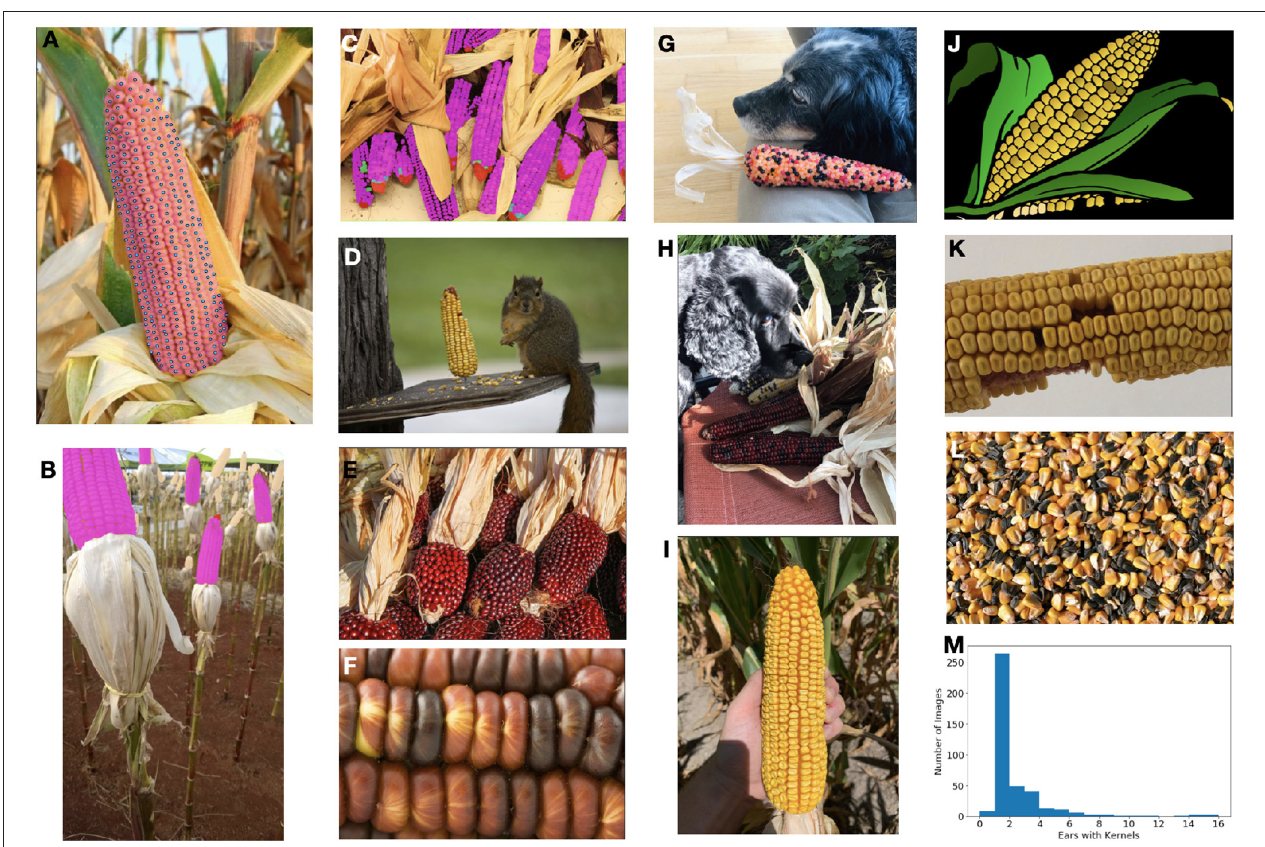
FIGURE 1 | The ultimate goal of this model is count and localize the healthy kernels on ears of corn. (A) Our dataset is densely labeled with per-instance segmentation masks (area shown in faded magenta with centers in blue). (B,C) In addition to healthy (magenta) kernels, we also label barren tips (red), incomplete/underdeveloped kernels (cyan), diseased kernels (green), and kernel areas (beige). (D–L) The dataset contains a diverse range of images with different types of corn, numbers and sizes of ears and kernels, photos and cartoon-imagery, shadowing and occlusion challenges, scales and resolution, as well as kernels which are loose, and therefore should be ignored. (M) The distribution of the number of ears in each image in the full